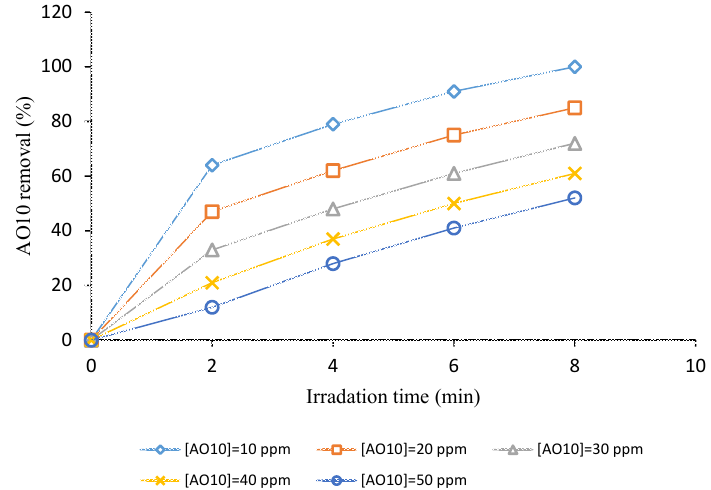
] = 0.25 g/100 mL, pH=3.5 2